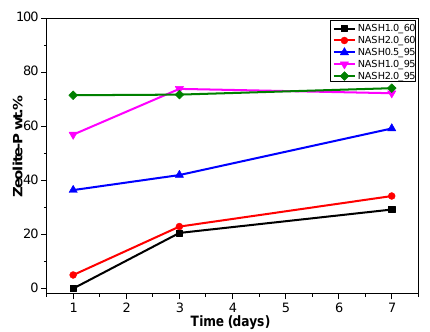
Figure 5. XRD patterns of N-A-S-H system product powders. ( a ) reaction at room temperature; ( b ) reaction at 60 °C; ( c ) reaction at 95 °C. (So: Sodalite; Fa: Faujasite; Z: Zeolite-P).